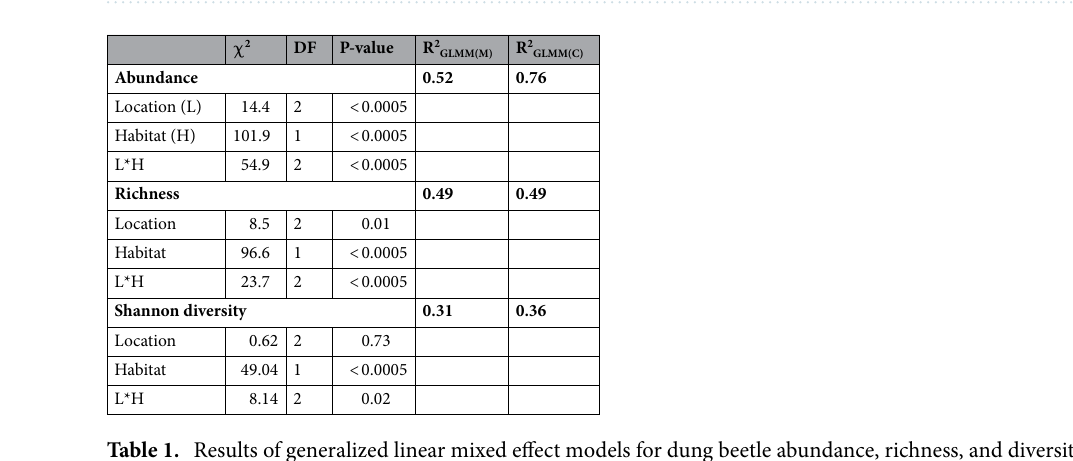
Figure 3. In pooled locations, dung beetle abundance, richness, and diversity were higher in home gardens than sacred groves. The sites of three locations are jittered on the box plots.